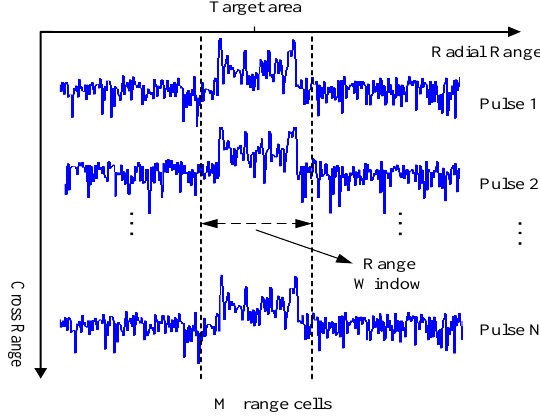
Figure 2. The received HRRPs in the CPI after MTRC compensation.